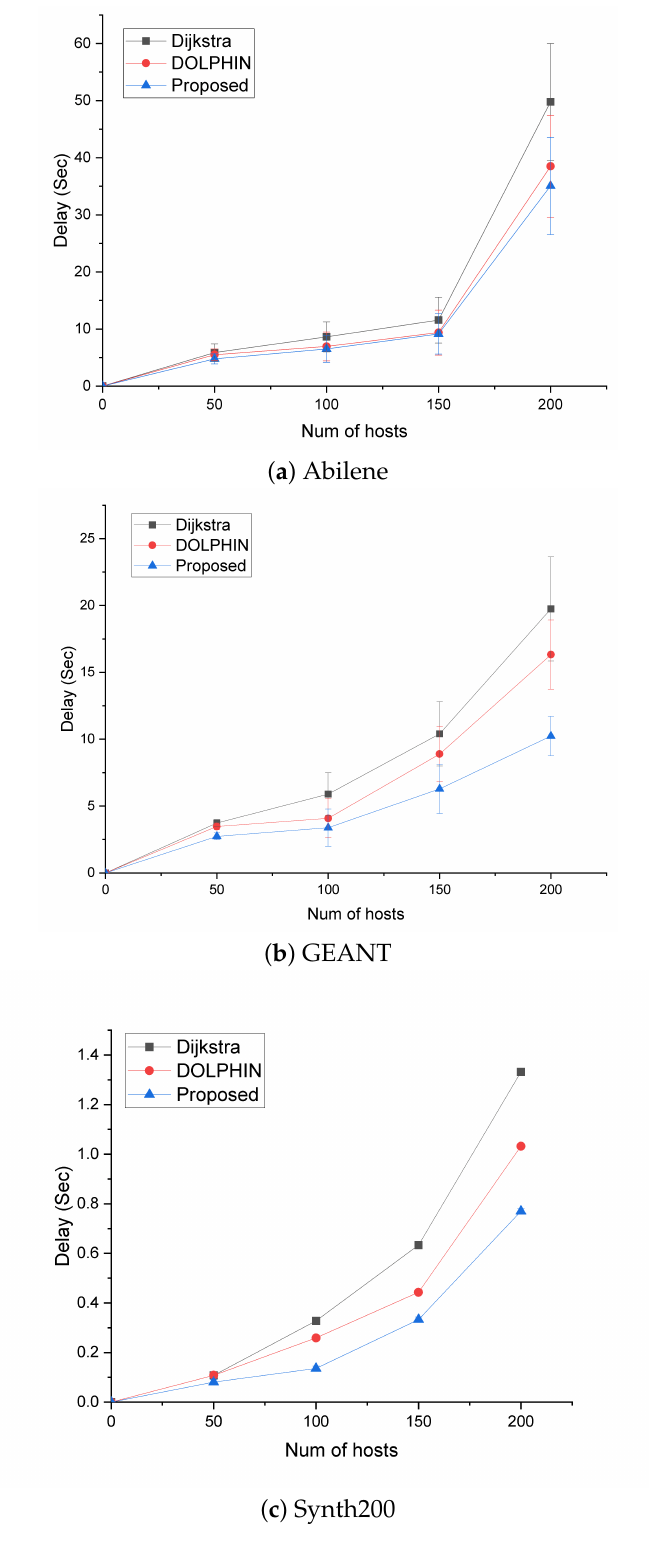
Figure 9. Average Delay according to the number of